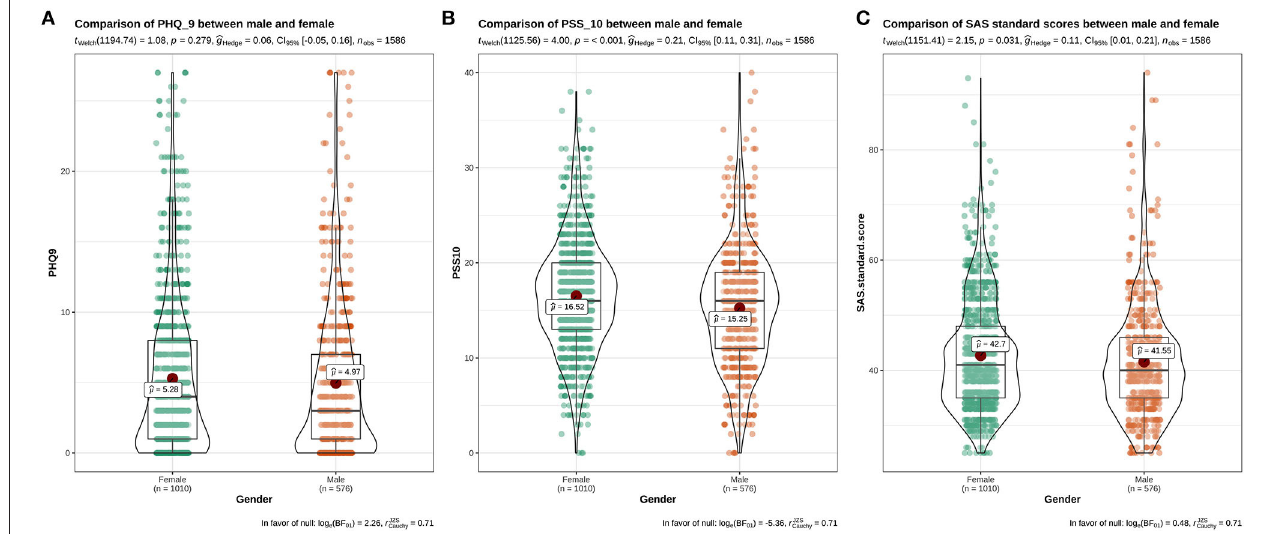
FIGURE 2 | The distribution maps of PHQ-9, PSS-10, and SAS scores of different genders. (A) Distribution of PHQ-9 scores in different genders; (B) Distribution of PSS-10 scores in different genders; (C) Distribution of SAS scores in different genders.